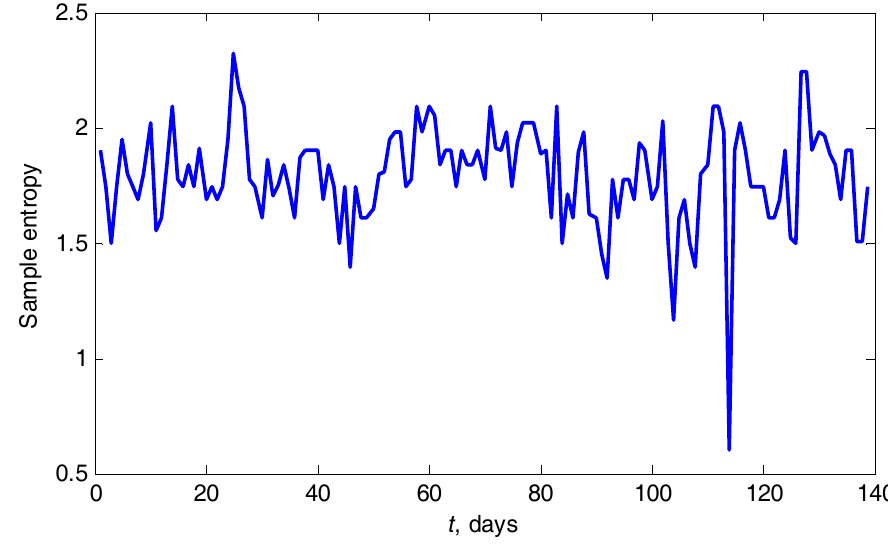
Figure 20. Sample entropy feature extracted from the vibration slew bearing signal.